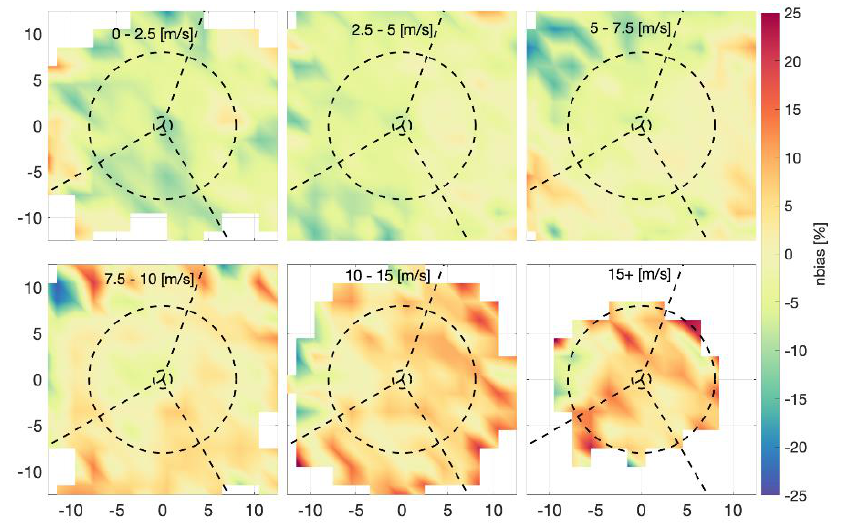
Figure 15. As in Figure 13, each subplot parsed by forward translation velocity.